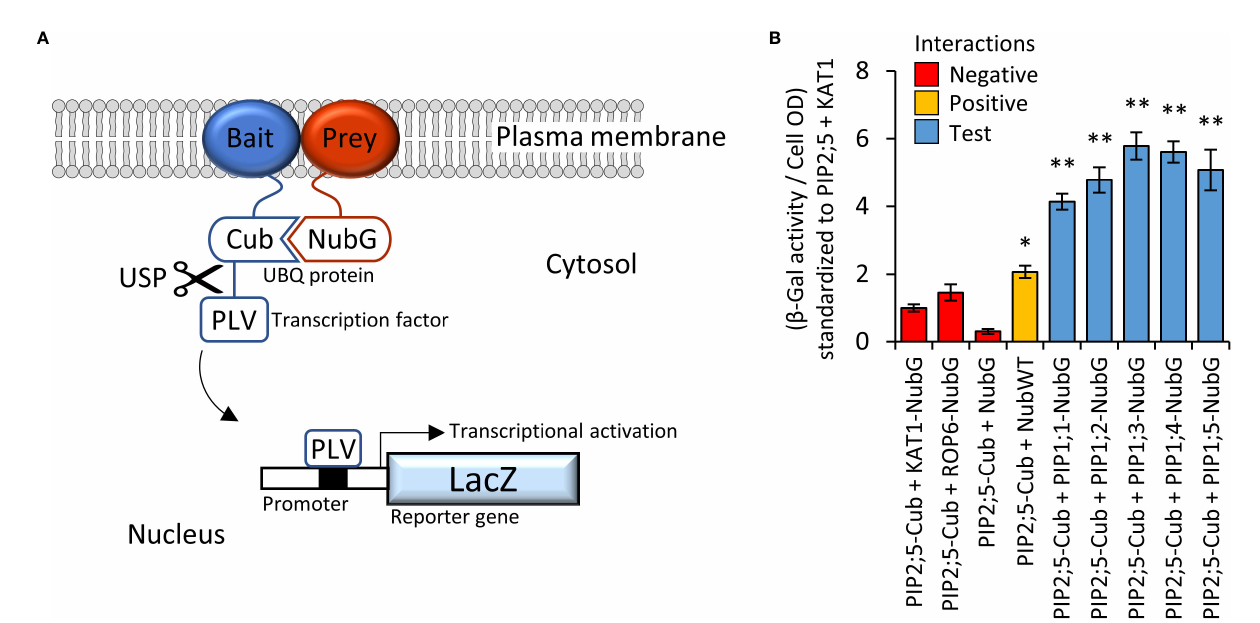
FIGURE 3 (A) , Illustration of mbSUS yeast two-hybrid system. The mutant N-terminal ubiquitin domain (NubG) and C-terminal ubiquitin domain (Cub) can reconstitute the full-length ubiquitin protein (UBQ) only when brought into close proximity via a membrane bound and interacting Bait and Prey